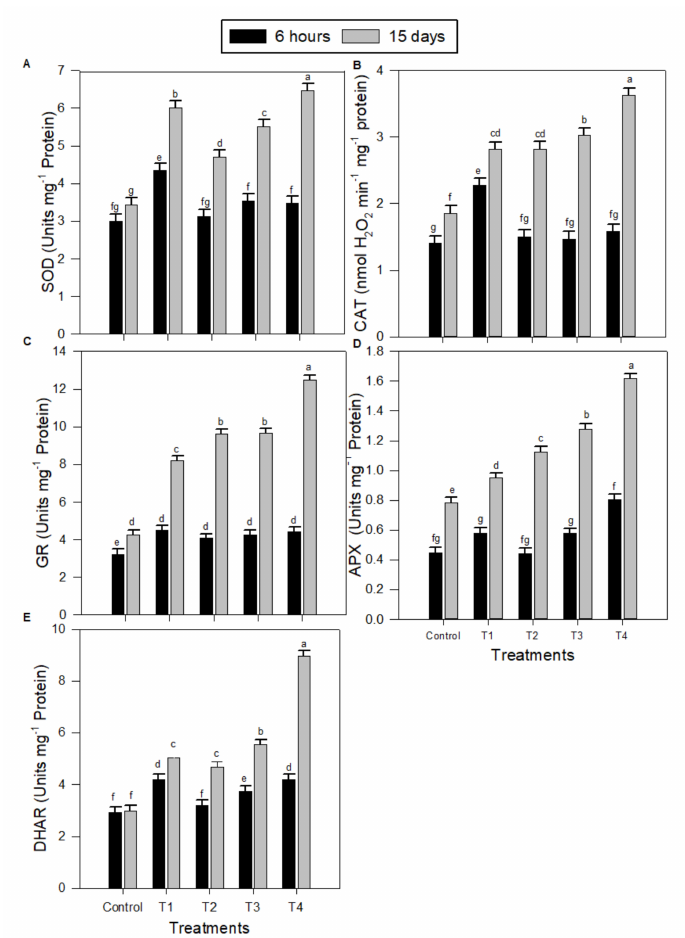
Figure 3. E ff ects of salinity stress combined with exogenous melatonin on the activities of antioxidant enzymes in peanut seedlings after 6 h and 15 days. ( A ) Superoxide dismutase (SOD), ( B ) catalase (CAT), ( C ) glutathione reductase (GR), ( D ) peroxidase (APX), and ( E ) dehydroascorbate reductase (DHAR). Data are means ± SD ( n = 3) from three independent experiments. The bars labelled with di ff erent letters are significantly di ff erent. The significant di ff erence marked by di ff erent letters was calculated using the Student’s t -test and further analyzed with the Fisher LSD test, at p ≤ 0.05. The legend is as follows: Control: 0 NaCl + 0 MT, T1: 150 mM NaCl + 0 MT, T2: 150 mM NaCl + 50 µ M MT, T3: 150 mM NaCl + 100 µ M MT, T4: 150 mM NaCl + 150 µ M